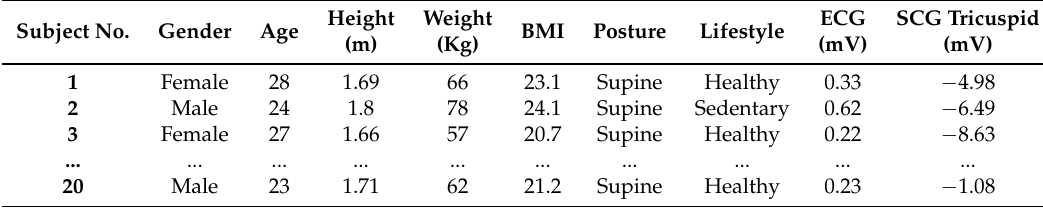
Table 4. Demographic information of the subjects.